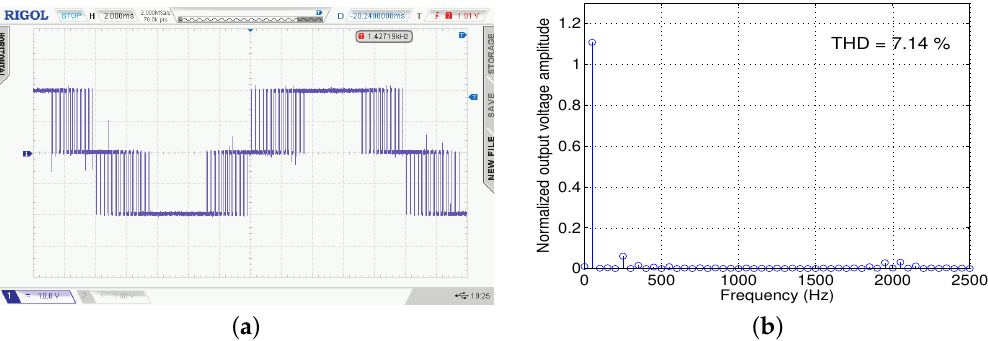
Figure 15. ( a ) Inverter output voltage with improved SPWM at m I = 1.2 and ( b ) Its frequency